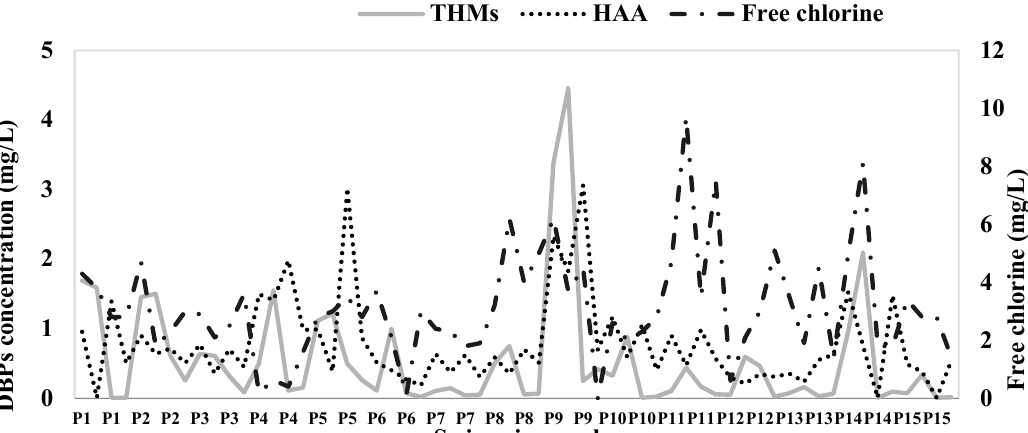
Figure 3. Residual free chlorine in the public pools selected for the study when sampled for the measurement of THMs and HAAs. In general, the residual chlorine influenced the concentration of THMs and HAAs. However, the speed of formation of the DBPs depends on the pH of the water in each pool. The average pH of swimming pool water was 7.55, with a maximum value of 8.45 and a minimum of 7.05. The pKa of hypochlorous acid is 7.53 (25 °C), indicating that the majority species in some pools was hypochlorite, and in others hypochlorous acid. Hansen et al. (2013) proved that formation of THMs increases in pools when pH is increased above 7.2 [21]. 3.3. Temperature Measured during the Monitoring of DBPs Figure 4 shows water temperature during sampling for the measurement of THMs and HAAs in the public pools selected for the study. The water temperature is very influential in the concentration values of THMs and HAAs.